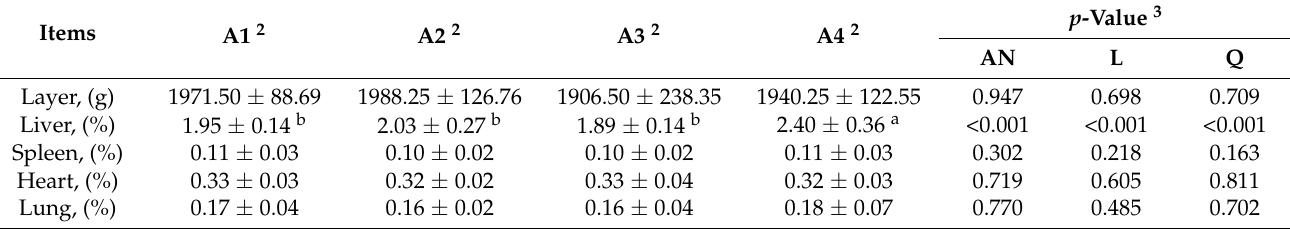
Table 5. Visceral coefficient of laying hens on week 12 (mean ± STD 1 ).